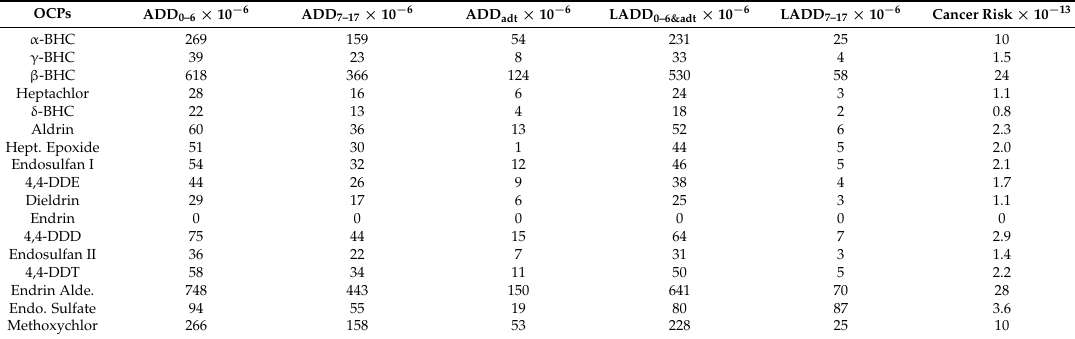
Table 6. Individual average daily dose (ADD), Life average daily dose (LADD), and Cancer risk of OCPs in summer and autumn.